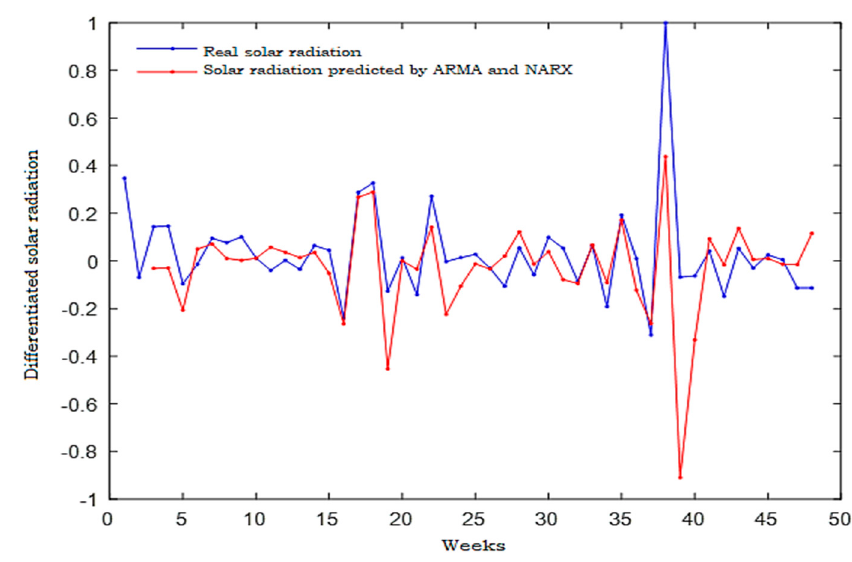
Figure 36. Prediction of solar radiation using the proposed hybrid model (ARMA and NARX). Table 15. Hybrid model performances (ARMA and NARX).